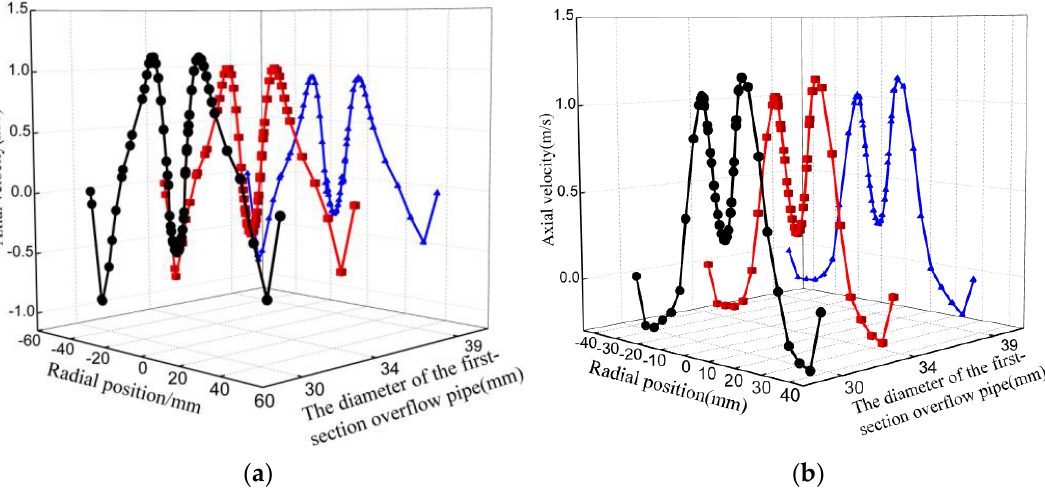
Figure 6. Effect of the first-section overflow pipe diameter on axial velocity ( a ) Cross-section of Z 1 ; ( b ) Cross-section of Z 2.